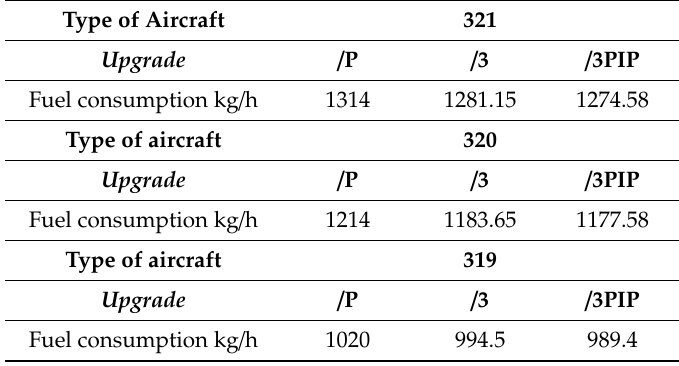
Table 2. Fuel consumption for individual engines upgrades and aircraft